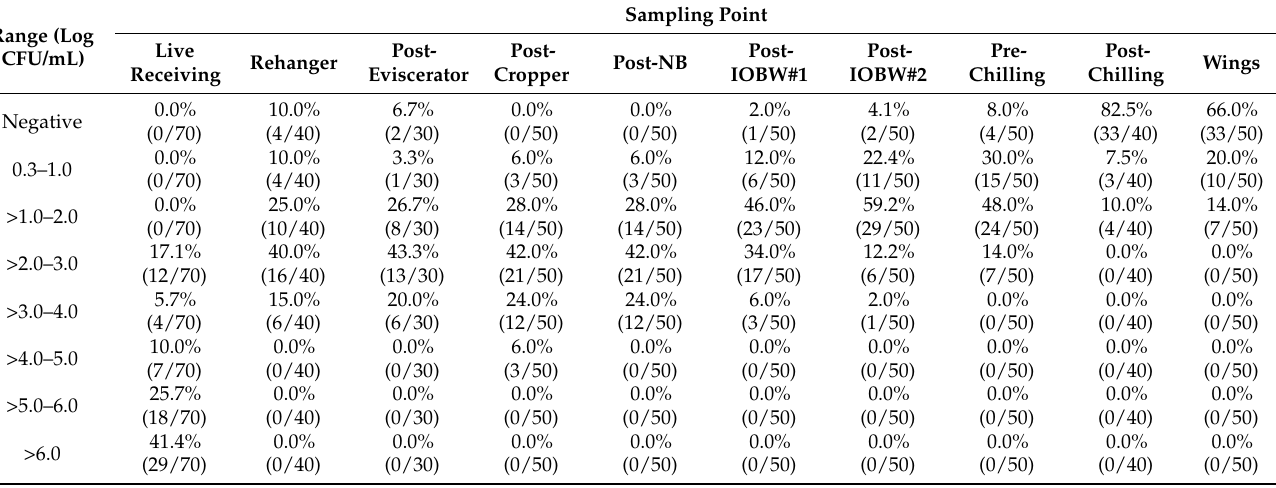
Table A7. Distribution of Campylobacter counts (Log CFU/mL) on each of the ten sampling locations under normal process intervention on chicken and part rinses (n = 910 samples).